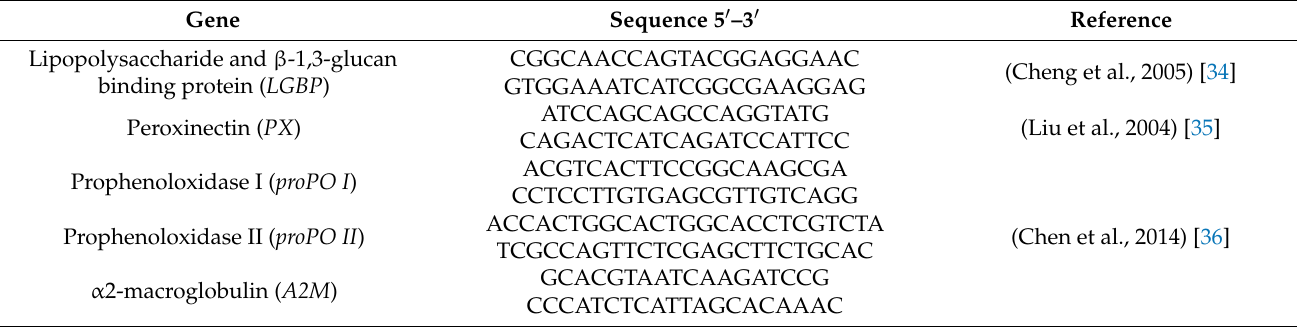
Table 1. Primers used in this